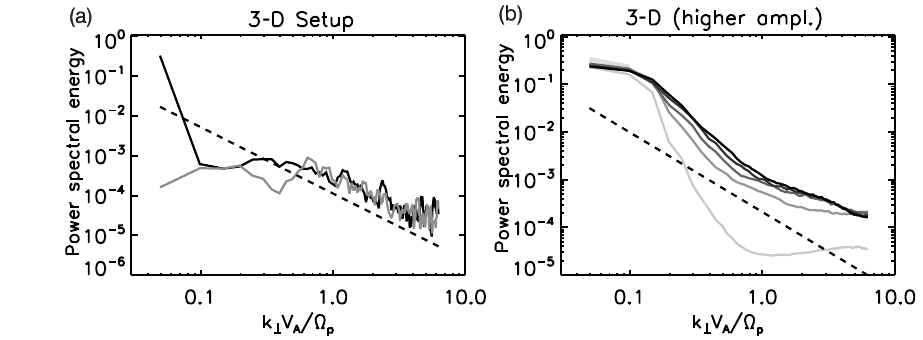
Figure 3. (a) One-dimensional wavenumber spectra of magnetic field fluctuations for a cut along the perpendicular-1 axis at time 500 (cid:127) − 1 p for the actual run (black) and for a run without initial pump (gray). (b) Reduced magnetic energy spectrum (normalized to their initial value) obtained for higher amplitudes of the pumping waves at a time step of 100 (cid:127) − 1 p plotted by an incremental level of gray, starting with time 0 (light gray) and ending at time 500 (cid:127) − 1 p (black). As reference, the dashed line is the Kolmogorov value of the spectral slope − 5 / 3.